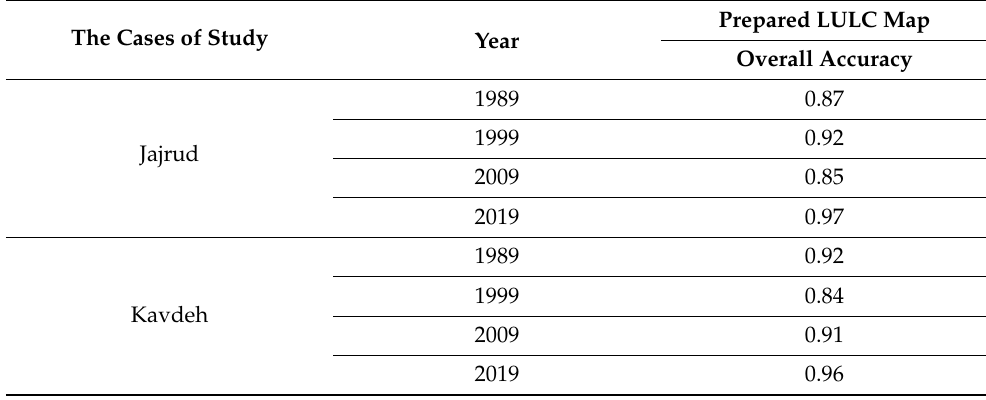
Table 4. Overall LULC classification accuracy achieved from using Landsat imagery for two Protected Areas in the Tehran province, Iran, for the time period of 1989–2019.